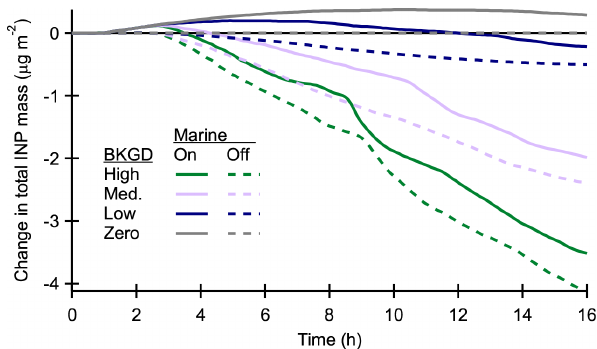
Figure 4. Changes in the column-integrated INP mass from the ini- tial values. The initial values for the four different background INP concentrations (high, medium, low and zero) are 9.6, 4.8, 1.0 and 0.0µgm − 2